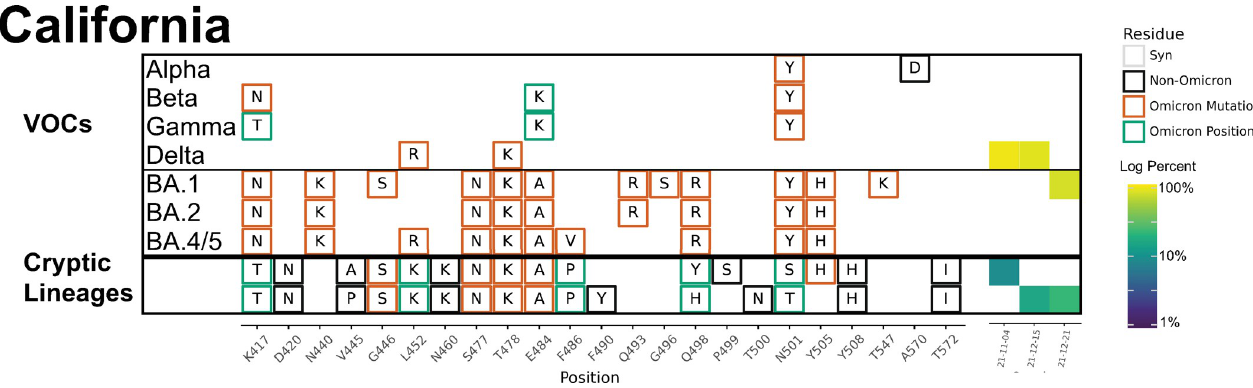
Fig 6. Overview of the SARS-COV-2 Spike RBD lineages identified from the California sewershed. Amino acid changes similar to (green boxes) or identical to (orange boxes) changes in Omicron (BA.1, BA.2 or BA.5) are indicated. Synonymous changes (syn) are indicated in gray. The major VOCs during this time period (Alpha, Beta, Gamma, BA.1 and BA.2) are indicated. The heatmap (right) illustrates lineage (row) detection by date (column), colored by the log 10 percent relative abundance of that lineage. Uncondensed output in S9